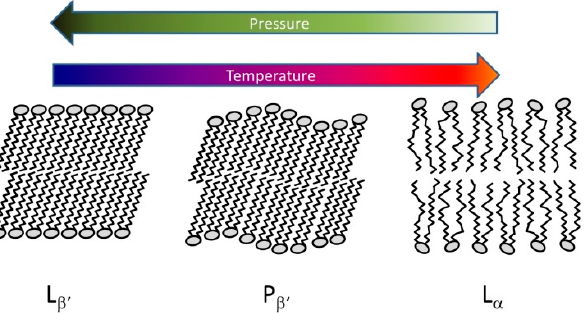
Figure 3. Typical lamellar lipid structures. L β ’ : gel phase with tilted chains, P β ’ periodic rippled structure with tilted chains, L α : fluid-like liquid crystal phase.